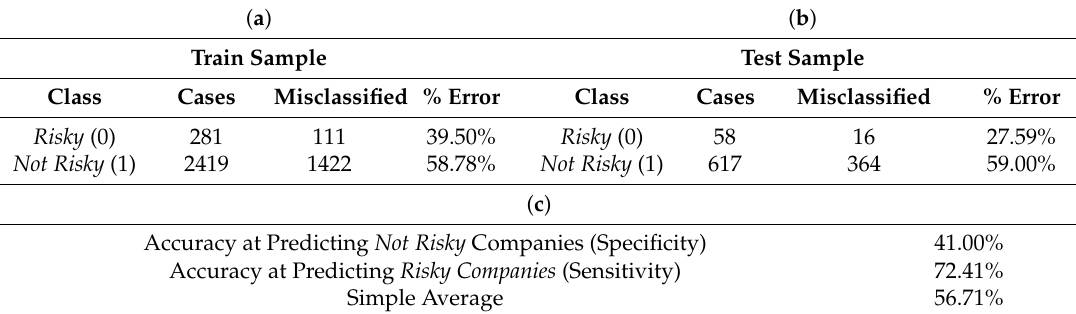
Table 5. ( a ) Optimised LR-train sample; ( b ) optimised LR-test sample; ( c ) LR model accuracy (test sample) with optimised cut-off